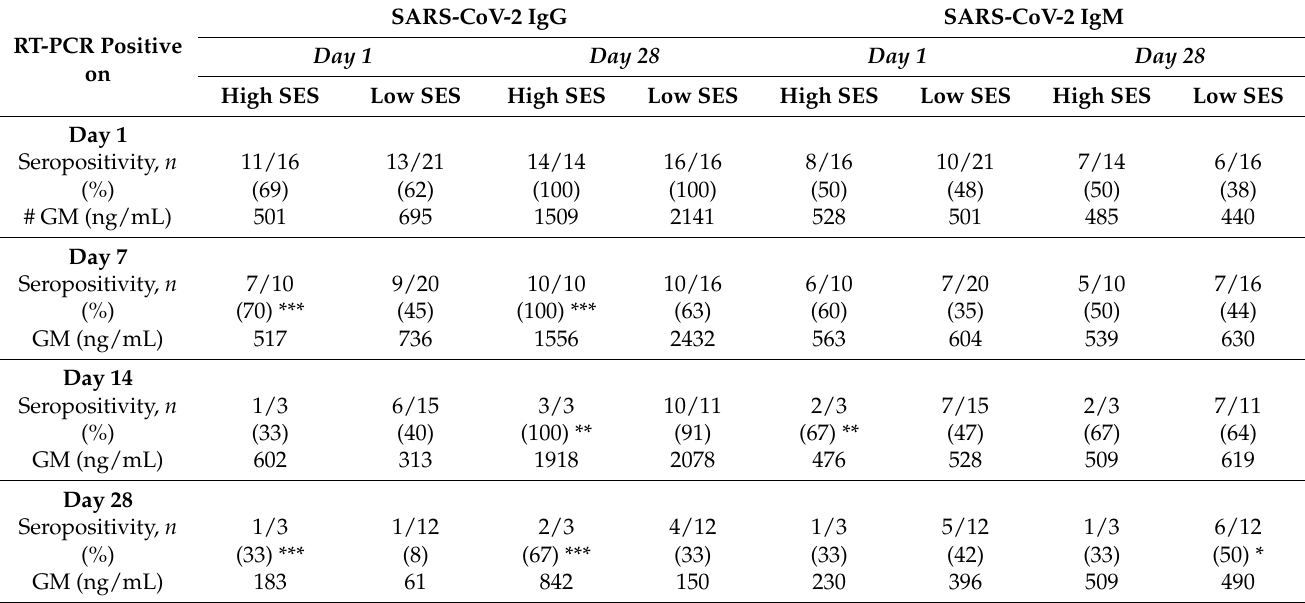
Table A1. Response rate and levels of SARS-CoV-2 antibodies in RT-PCR-positive contacts with high-SES and low-SES in Dhaka city.